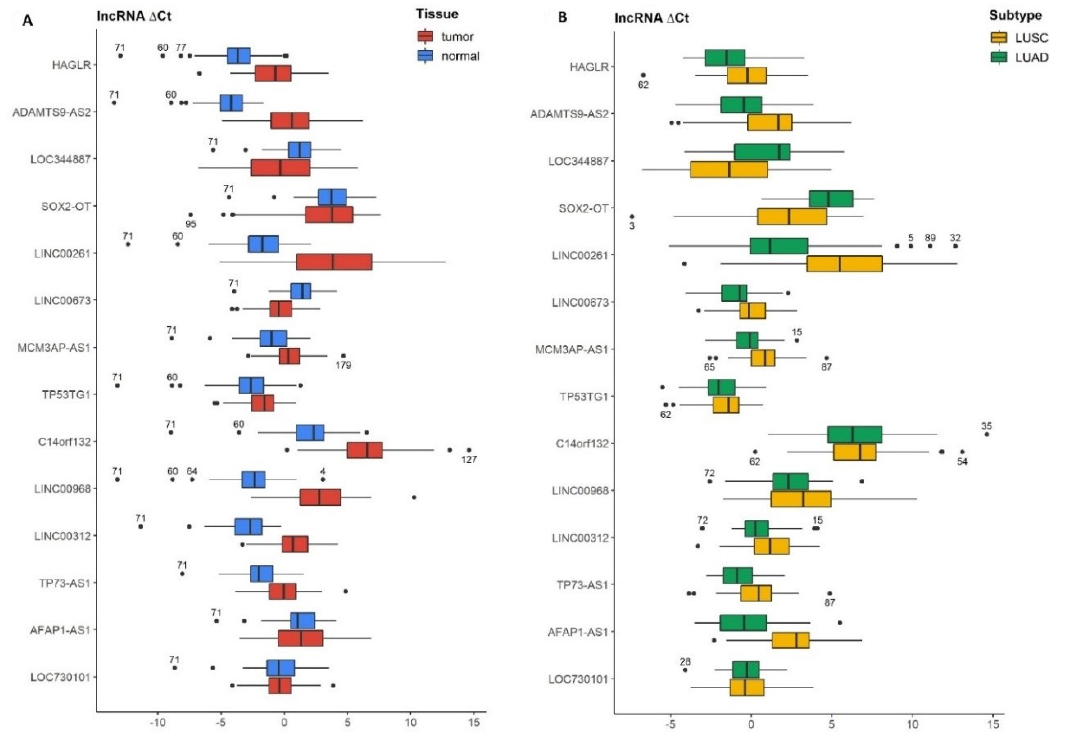
Figure 1. Visualization of differences in the delta Ct distributions across all lncRNAs. Additional numbers indicate the IDs of the furthest outlier patients in data: ( A ) Differences between the cancerous and noncancerous lung tissue. Two patients with extreme delta Ct values of multiple lncRNAs are observed (60 and 71); ( B ) Differences between the LUSC and LUAD subtypes of the tumor tissue. No patients with multiple extreme delta Ct values are